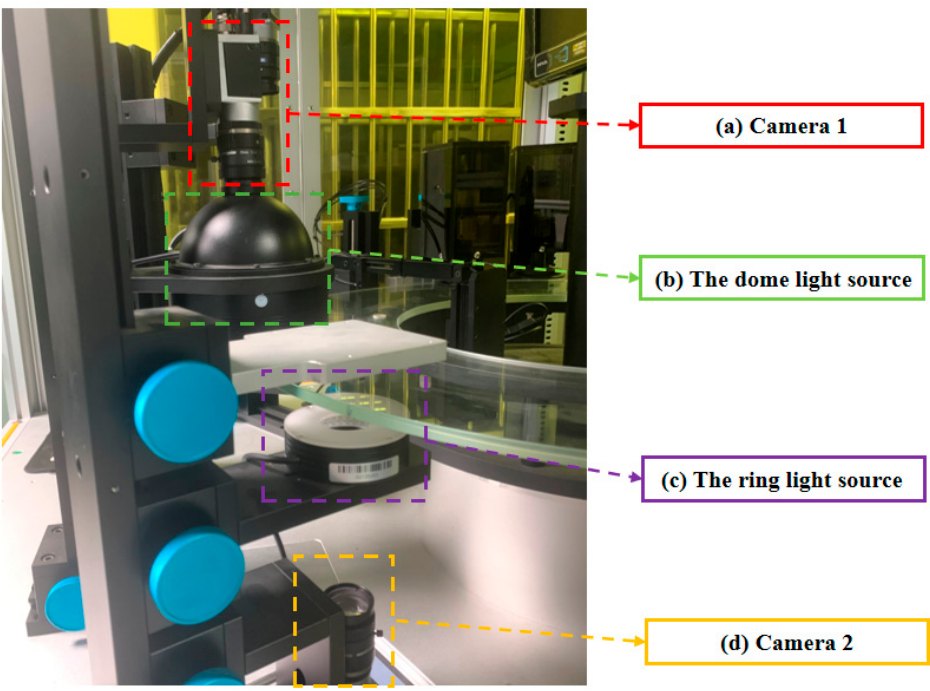
Figure 7. Experimental equipment layout. Table 4. Detailed parameters for each component.